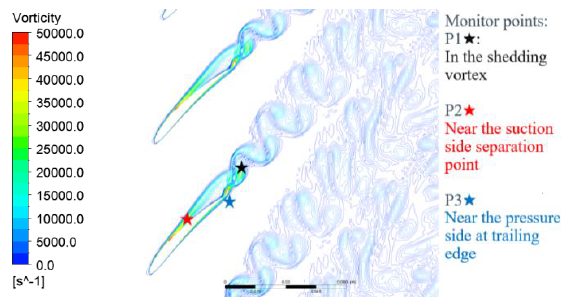
Figure 6. Instantaneous vorticity contour at working point